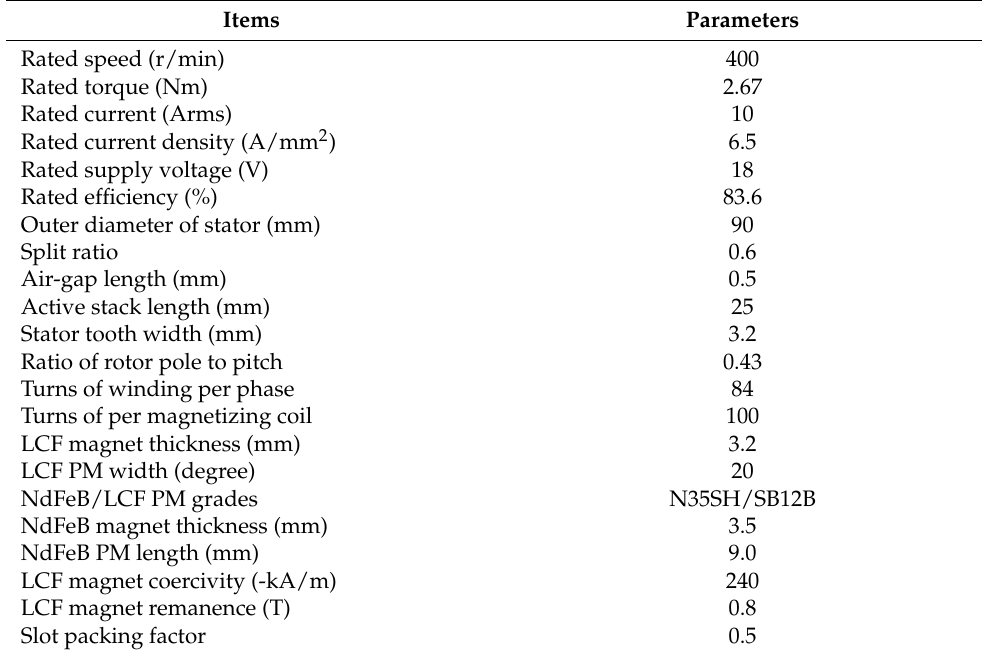
Table 2. Design Parameters of 6-Stator-Slot/13-Rotor-Pole SF-HMMM